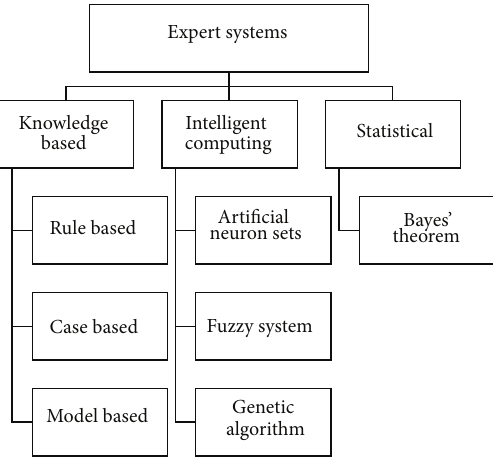
Figure 1: Common methodologies for expert systems.